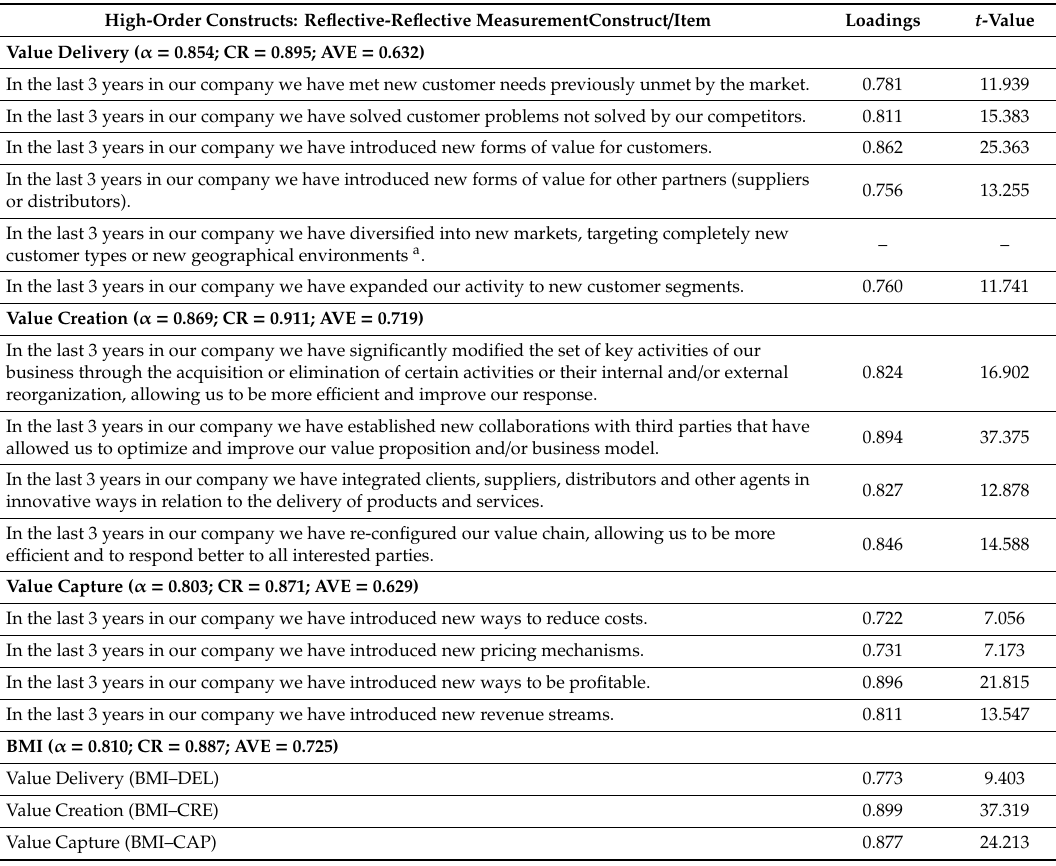
Table A2. Questionnaire: